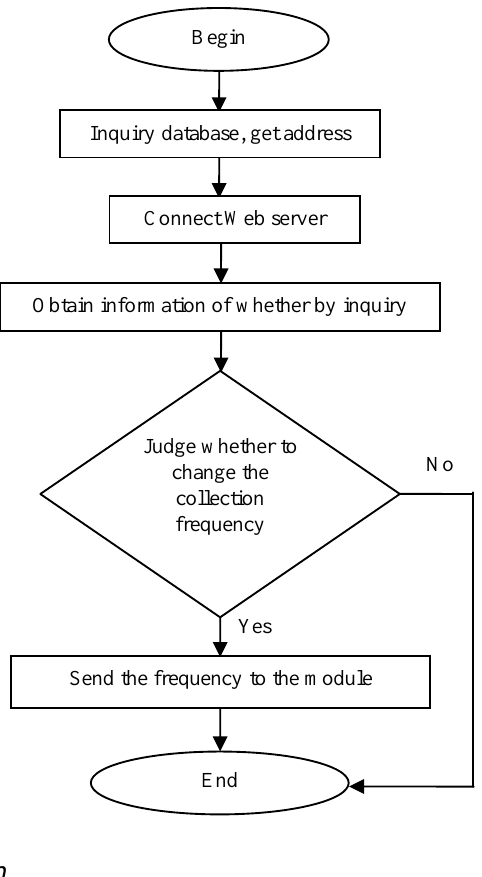
Figure 8. The flow chart of the underground water